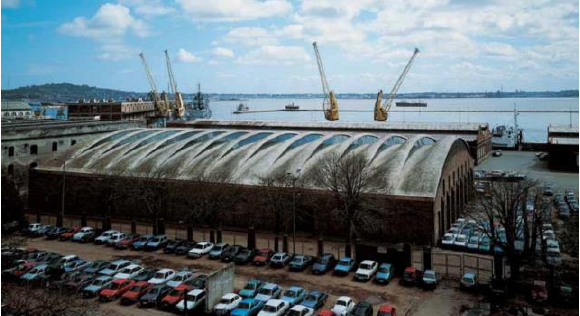
Figure 5: Seaport Deposit of Montevideo. Designed and built by Eladio Dieste in 1979